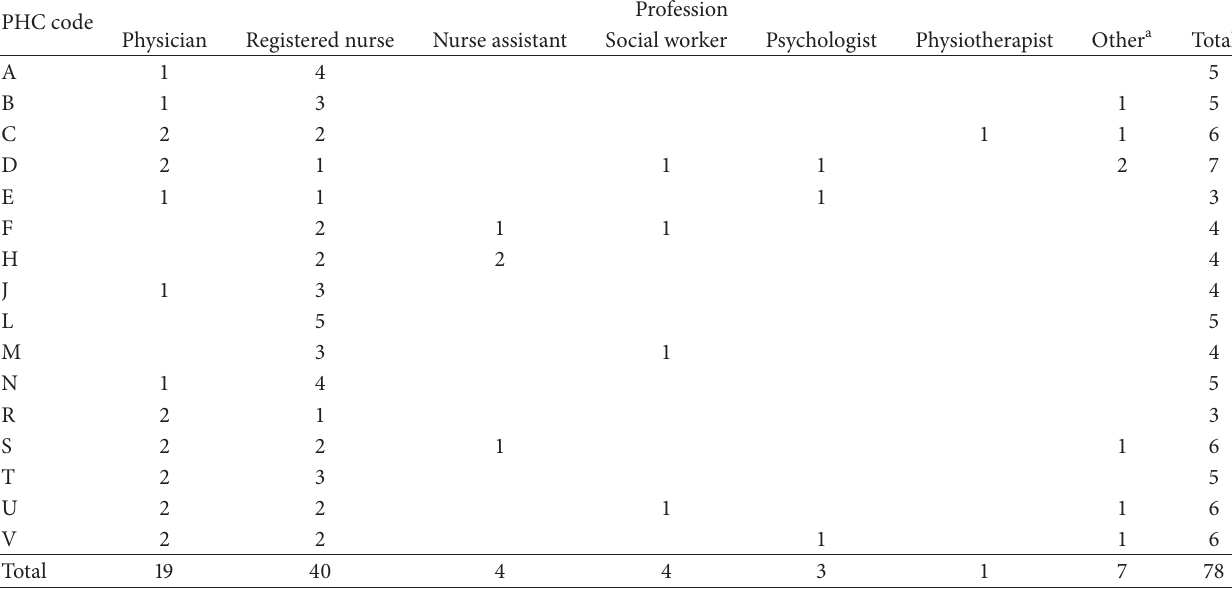
Table 1: Distribution of participants in the focus group interviews at baseline in the SPIRA study.